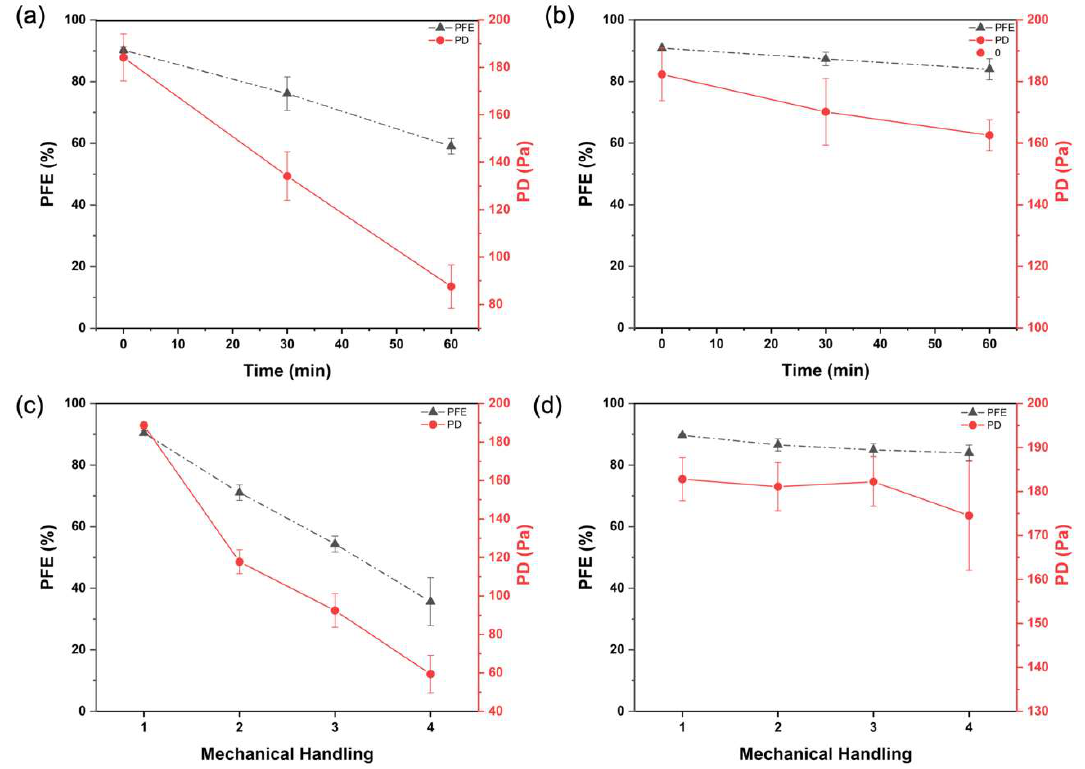
Figure 4. PFE and PD of ( a ) uncrosslinked zein filter with different time of conditioning, ( b ) cross- linked zein filter with different time of conditioning, ( c ) uncrosslinked, and ( d ) crosslinked zein filter mechanical after mechanical handling.